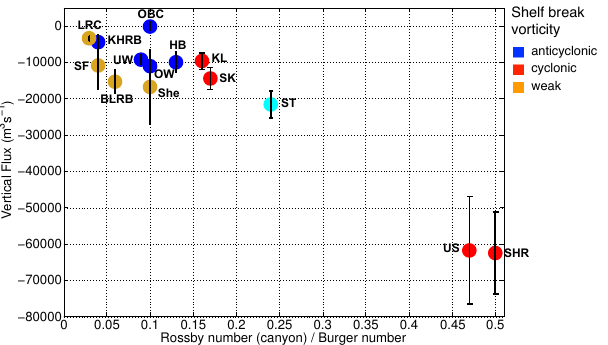
Figure 16. Burger number effect on average density anomaly in canyon for all simulations (averaged between model days 4 and 10).